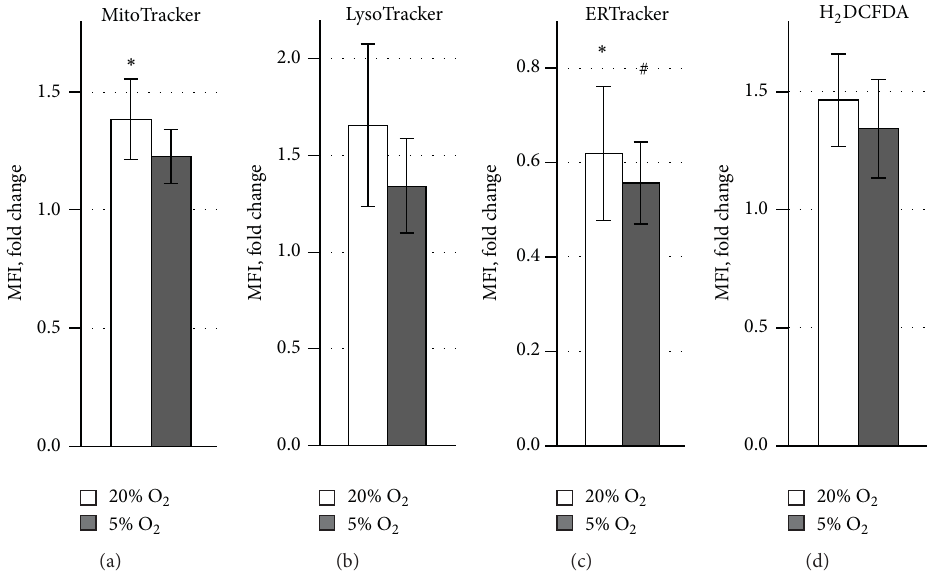
Figure 3: Cellular organelle state and ROS level in ASCs after coculture with PHA-stimulated PBMCs versus ASCs in monoculture. Transmembrane mitochondrial potential (a), lysosome activity (b), endoplasmic reticulum activity (c), and ROS production (d). ∗ Significant difference between monocultured and cocultured ASCs at 20% O 2 ( 𝑝 < 0.01 ). # Significant difference between monocultured and cocultured ASCs at 5% O 2 ( 𝑝 < 0.01 ).